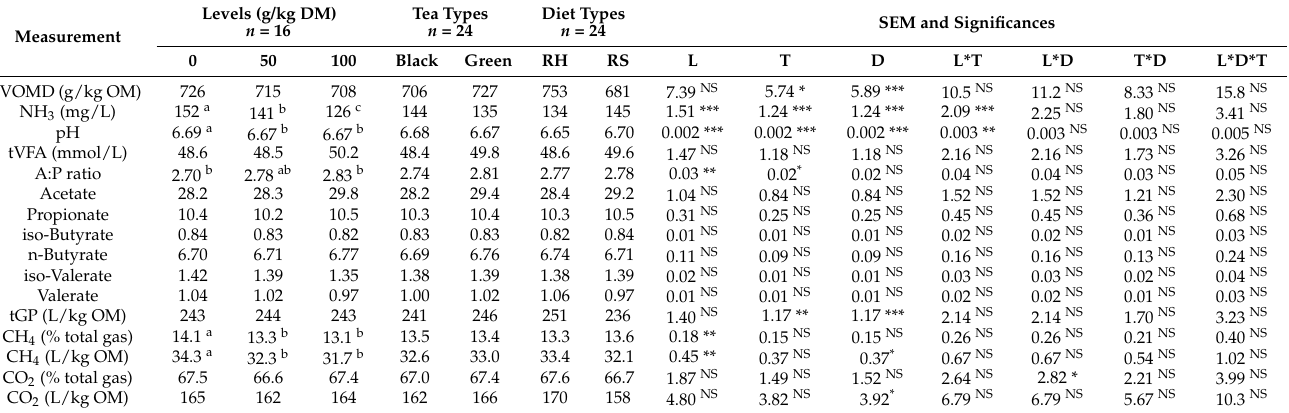
Table 5. Mean values of in vitro rumen measurements at 24 h incubation time for the main effect of inclusion levels (L, g/kg DM), tea types (T), diet types (D) and their interactions with SEM and